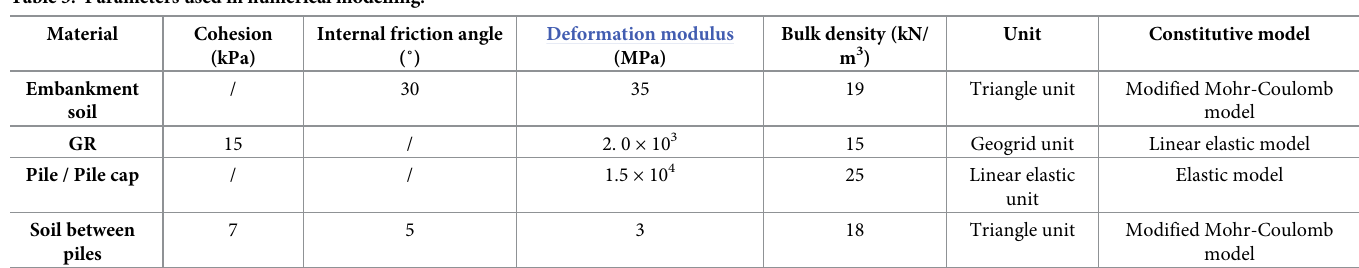
Table 3. Parameters used in numerical modelling.